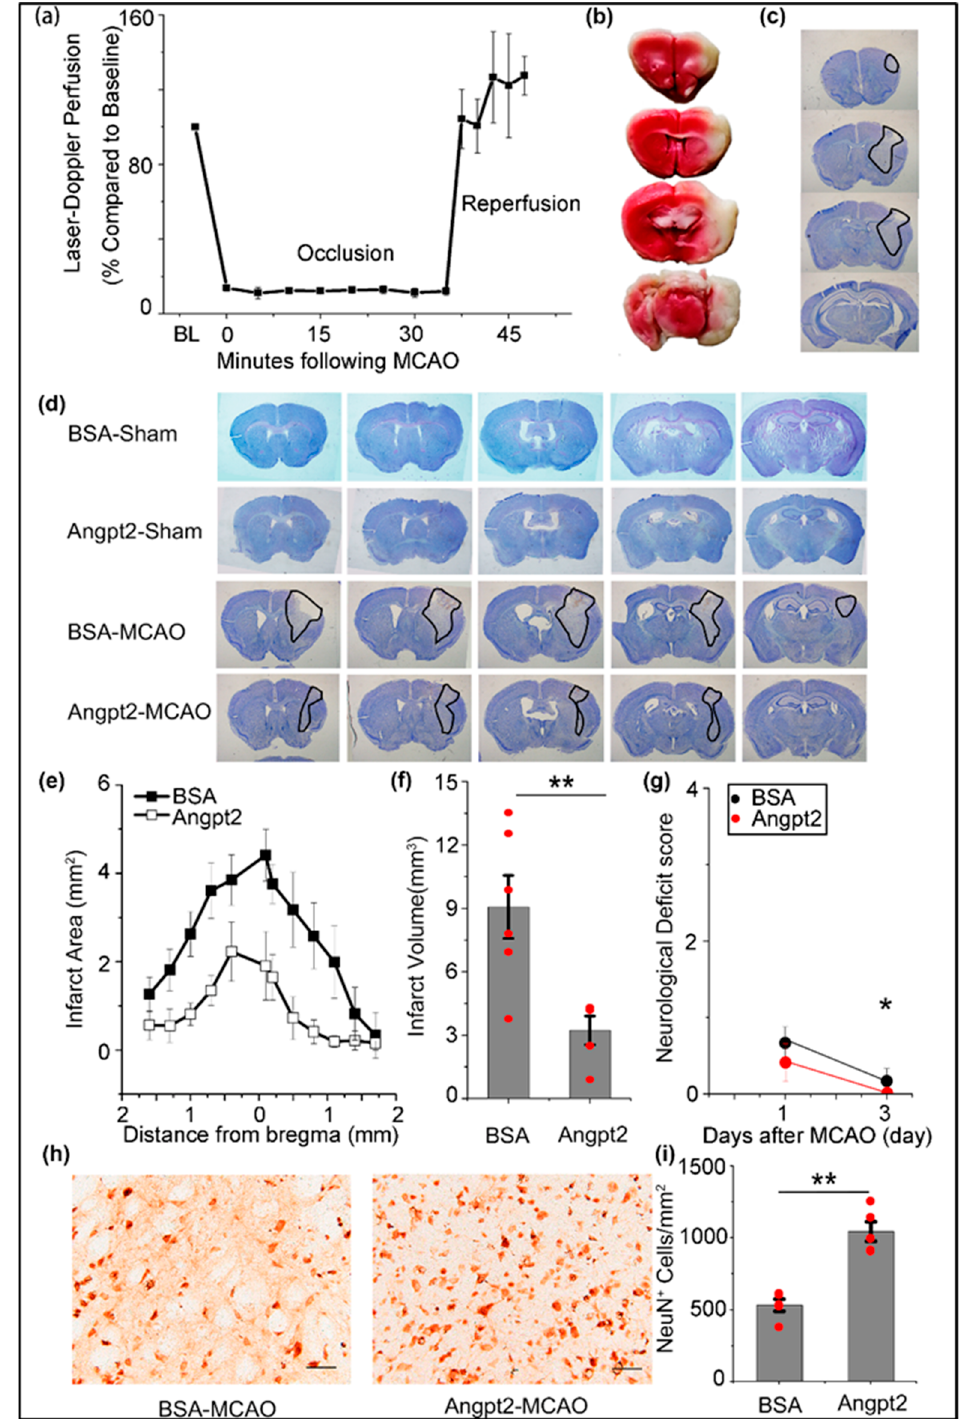
Figure 1. Angiopoietin 2 (Angpt2)exerted a neuroprotective effect by reducing brain infarction in mice brains after ischemic stroke. ( a ) Laser Doppler flowmetry changed through an intraluminal middle cerebral artery occlusion (MCAO) procedure. The baseline blood flow was considered to be 100% for all mice. ( b ) TTC-stained sections of mouse, 3 days after MCAO. The normal brain tissue was stained red, while the ischemic tissue remained unstained. ( c ) Cresyl violet staining in a representative whole section image. The normal brain tissue was stained blue, while the ischemic tissue marked by black lines remained unstained. ( d ) Representative whole section image showing CV staining in the BSA-Sham, Angpt2-Sham, BSA-MCAO and Angpt2-MCAO groups 3 days